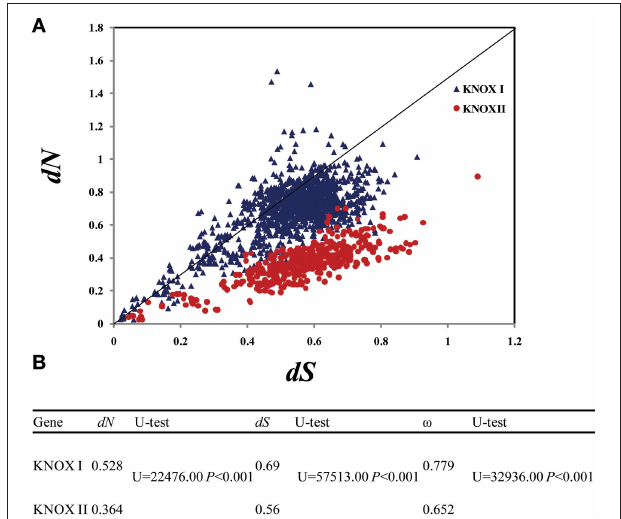
FIGURE 4 | Evolutionary rates of class I and class II KNOX genes. The species analyzed were Physcomitrella patens , Selaginella moellendorffii , Oryza sativa , Zea mays , Arabidopsis thaliana , Populus trichocarpa , and G. max. (A) Evolutionary rate of the KNOX I and KNOX II genes. dN , non-synonymous substitution rate; dS , synonymous substitution rate. (B) Comparison of the evolutionary rage, the average values of the KNOX I and KNOX II genes, Utest: Mann-whitney Rank sum test.